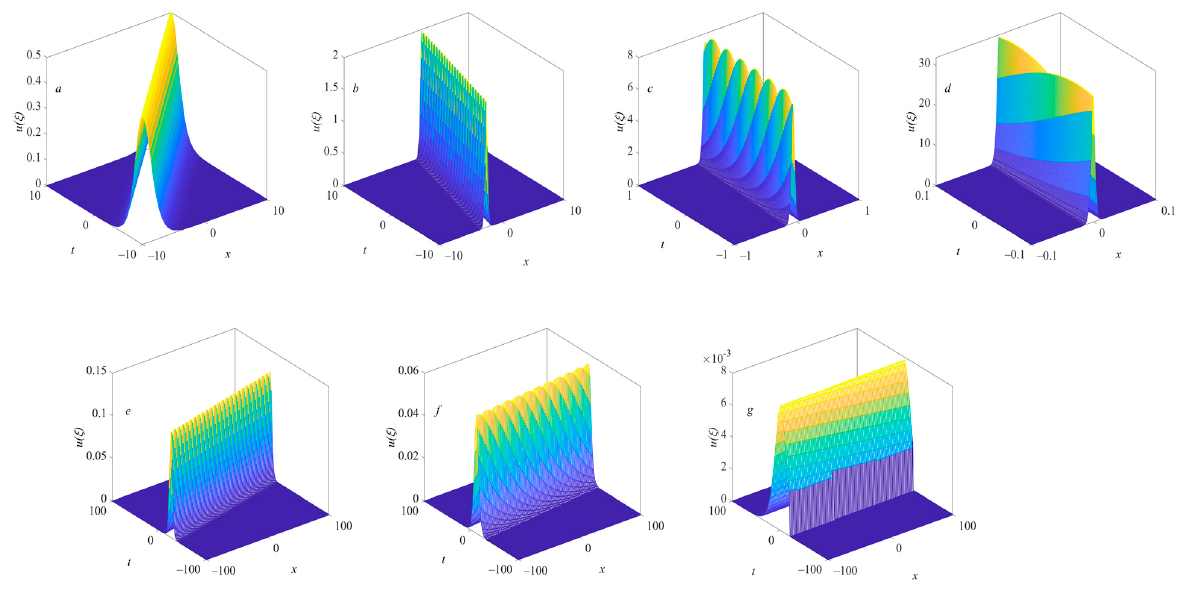
Figure 2. Evolution of solitary waves with n in u 2 n when k = 1, λ = 1, ν = 1, ε = 1, r = 1: ( a ) n = 1, ( b ) n = 2, ( c ) n = 4, ( d ) n = 8, ( e ) n = 1